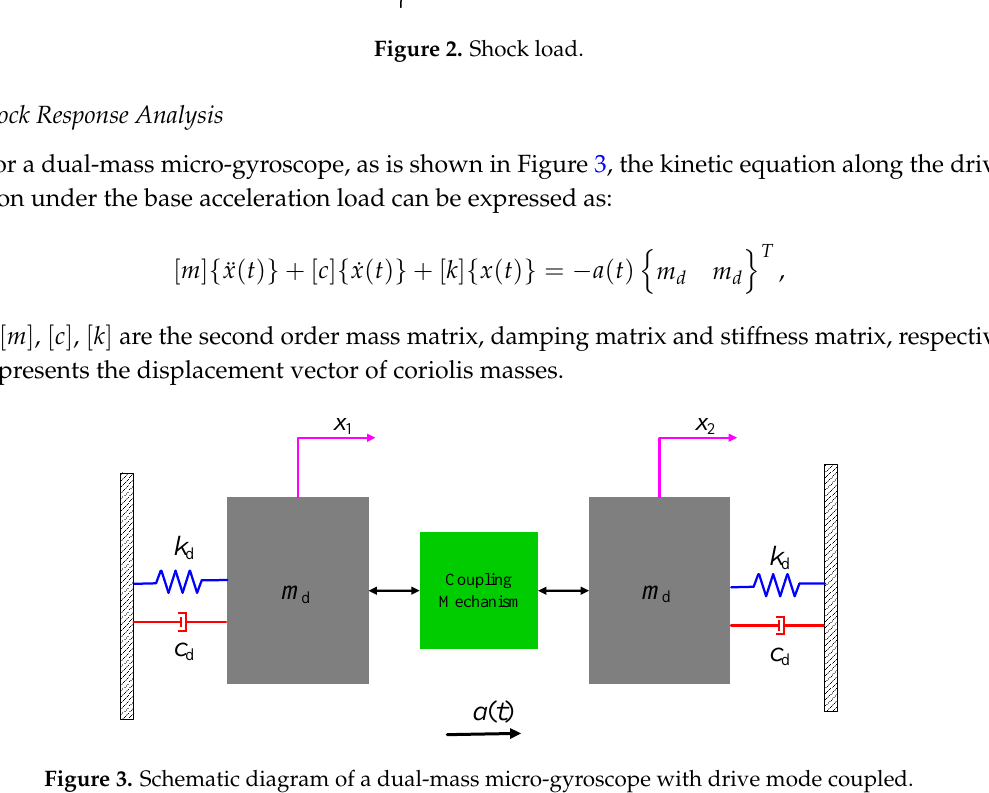
Figure 3. Schematic diagram of a dual-mass micro-gyroscope with drive mode